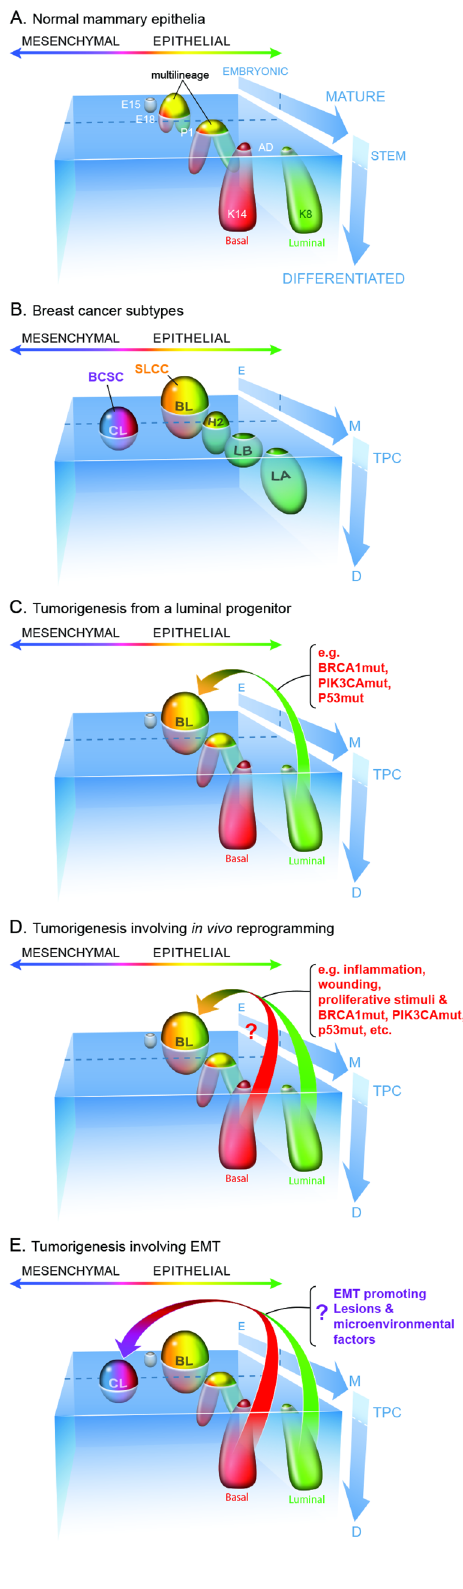
Fig. 3 Diverse states of the normal and neoplastic mammary epithelium relative to development, stem cell differentiation, and epithelial/mesenchymal phenotypes. a Changes in potential for cells to enter the stem cell state throughout development can be conceptualized in a coordinate space that relates stem cell abundance and differentiation (y-axis) with developmental progres- sion (z-axis) and epithelial/mesenchymal phenotypes (x-axis). The various cell types within the mammary epithelium occupy distinct regions in this space over the course of development (as also proposed by Granit et al.). 152 b The different intrinsic subtypes of breast cancer occupy some of the same space as the normal mammary epithelium leading to partially shared gene expression pro fi les and operative molecular mechanisms. We suggest using tumor propagating cell (TPC) as a general term to describe cells able to generate and propagate tumor xenografts. These cells are expected to exhibit cell state plasticity to generate intra-tumoral heterogeneity in either immune compromised mice when assaying human tumor cells, or immune intact mice when using isogenic mouse cells for analysis. It remains to be determined whether TPC initiate or propagate tumors in humans. TPC may either be mesenchymally oriented as are classic “ cancer stem cells ” such as BCSC, or they may resemble the more SLCC that share similarities with fMaSCs. CL Claudin Low, BL basal like, H2 Her2-like, LB luminal B, LA Luminal A. Inter-tumoral and intra-tumoral heterogeneity may further rest on local differences in expression of key regulators (e.g., Sox10, Cripto) – the expression and activity of which can be affected by autocrine or paracrine factors produced in the epithelium or microenvironment. Furthermore, genetic background and microenvironmental in fl uences including immune responses and local and systemic stresses may impact aggressiveness by shifting the thresholds that distinguish stem cells from non-stem cells. c a model involving the generation of a tumor from a luminal progenitor. The Luminal progenitor already harbors some stem cell characteristics, such as cell state plasticity and a higher proliferative index that may facilitate epigenetic reprogramming to bipotenti- ality. Luminal progenitors appear to dedifferentiate into a bipotent- like state by activation of diverse oncogenic pathways and loss of tumor suppressors previously associated with BLBCs. d More mature cells may also have tumorigenic potential following tissue disrup- tion, in fl ammation or other proliferative stimuli that induce facultative stem-like phenotypes. If these in fl uences promote plasticity and reprogramming in situ, the resulting stem cell-like tumors could in fact derive from a variety of precursor cells. e The cell or cells of origin of Claudin low tumors remain to be de fi ned, and this fi gure presents mechanisms for their genesis involving intrinsic or extrinsic EMT promoting signals. The genesis of these tumors may also depend upon induction of phenotypic plasticity and tumor cell-associated